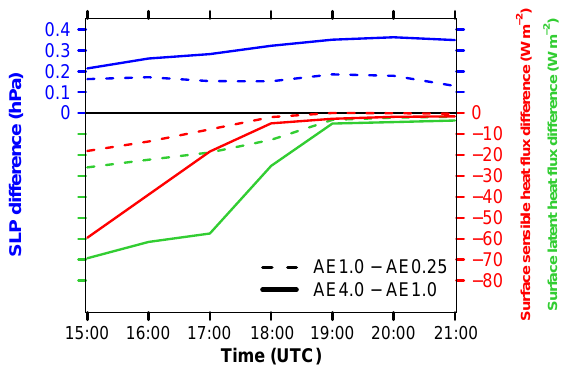
Figure 15. Temporal evolution of the differences in surface sensible heat flux (red, Wm − 2 ), surface latent heat flux (green, Wm − 2 ) and surface pressure (blue, hPa) between the reference and the clean case (dashed line) and between the polluted and the reference case (solid line) for the time period 2 July 15:00–21:00UTC spatially averaged for the AI prefrontal area over Ivory Coast as defined by the θ s method. The sensible heat flux is defined positive